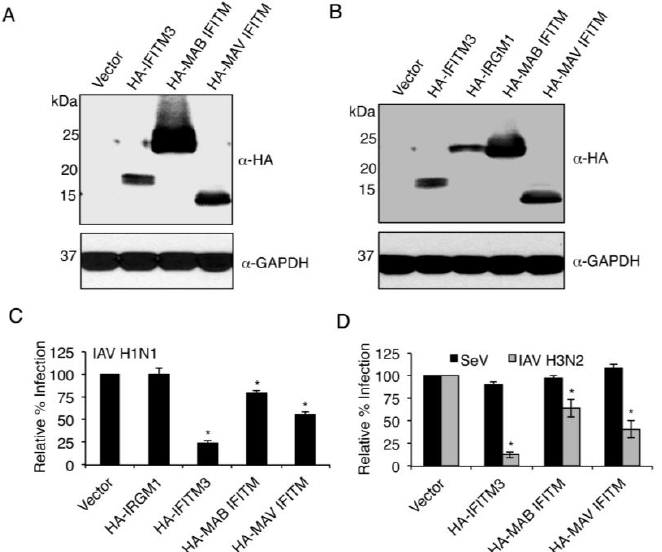
Figure 3. IFITMs from mycobacteria inhibit influenza virus infection when expressed in human cells. ( A ) HEK293T cells were transfected overnight with equal amounts empty vector or vector expressing human HA-IFITM3, HA-MAB IFITM3 or HA-MAV IFITM3. Lysates were analyzed by Western blotting with anti-HA antibody staining and anti-GAPDH staining as a loading control; ( B ) HEK293T cells were transfected overnight with equal amounts of empty vector, human HA-IFITM3, murine HA-IRGM1, or HA-MAV IFITM, or half the concentration of HA-MAB IFITM. Cell lysates were analyzed by Western blotting with anti-HA antibody staining and anti-GAPDH staining as a loading control; ( C , D ) Cells transfected as in B were infected with IAV H1N1 strain PR8 at an MOI of 2.5 or IAV H3N2 strain X31 or SeV at an MOI of 5.0. Cells were then collected and stained with anti-HA and anti-IAV nucleoprotein antibodies or anti-SeV antiserum. Cells were analyzed for percent infection by flow cytometry based on anti-IAV nucleoprotein or anti-SeV antibody staining in comparison to non-infected controls. The average percent infection for vector control cells was set to 1 for each infection. At least three independent experiments, each with triplicate measurements, were averaged and graphed. Error bars indicate standard errors of the means. * p < 0.01 compared to vector control by Student’s t test.